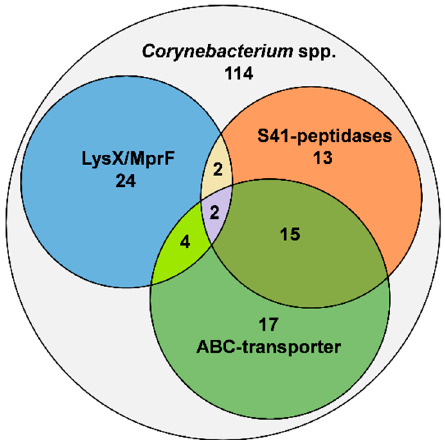
Figure 2. Distribution of LysX/MprF homologs (blue circle), S41-like NSR peptidases (orange) and two domain ABC-type transporters (green) in the genomes of 114 Corynebacterium spp. Each of the identified ABC-transporters contains a nucleotide-binding domain (NBD) and a single transmembrane domain (TMD). While this architecture appears similar to BceAB-type transporters, the permease subunit of e.g., C. casei only shares 25% sequence